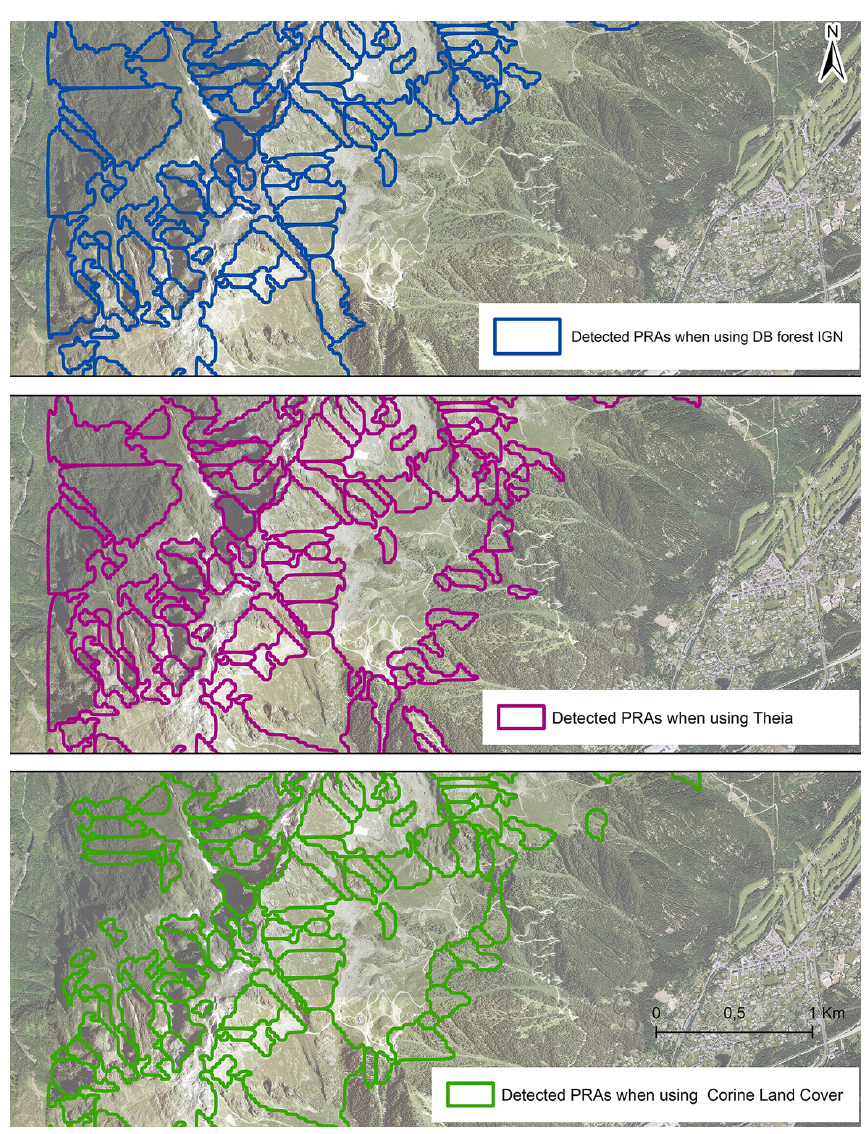
Figure 9. Effect of forest data source on detected PRAs, study area of Chamonix. For the PRA detection, the forest data source varies, and all other factors and the DEM resolution are set to their default values (Fig. 3). Aerial photograph © IGN 2015. For the determination of the validation sample, all factors and DEM resolution are set to their default values (Fig. 4) and forest cover data are from DB forest